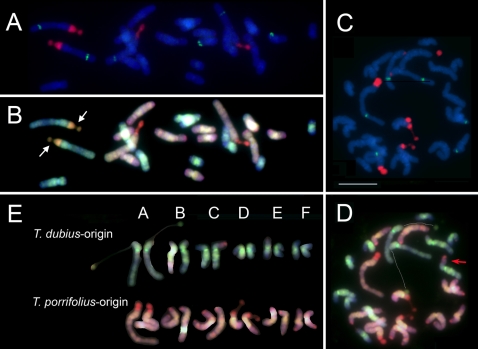
Analyses of root tip metaphases of synthetic T. mirus (A, B is plant 73-14; C-E is plant 134-16-3).(A, C) Metaphase (merged images) after FISH for 45S rDNA (red) and 5S rDNA (green) and counterstained with DAPI (blue). (B) and (D) Metaphases (merged images) from (A) and (C), respectively, after reprobing using GISH with labeled genomic DNA from T. porrifolius (pink) and T. dubius (green) and counterstained with DAPI. In (B) note the particularly there are only four 45S rDNA sites, the sites on Adu. Chromosomes are particularly large (arrows) and the site expected on chromosome Dpo is missing. In (D) note the T. porrifolius translocation to a T. dubius chromosome (red arrow) and the satellites to both Adu homologues are distant from the rest of the chromosome (see connecting white lines). (E) Karyotype of (D) revealing that the T. porrifolius origin translocation is to chromosome Cdu and that no T. porrifolius chromosomes lack chromatin. Scale bar is 10 µm.